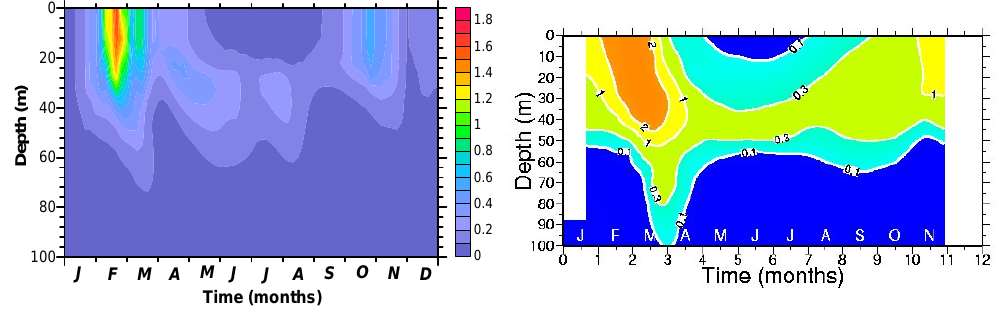
Figure 17 demonstrates seasonal variability of the nitrate and zooplankton concentrations in the upper layer of the Black Sea. Surface concentration of nitrate increases during the winter mixing period and reduces to small value after the spring bloom of phytoplankton. Then it remains negligible until the next winter. The distribution of zooplankton follows closely that of phytoplankton with a time lag of approximately half a month. These seasonal cycles of the phytoplankton, zooplankton and nitrate in the upper layer of the Black Sea derived from the modeling qualitatively correspond to those obtained from measurements (Oguz et al. 1999). Fig. 17. Seasonal cycles of averaged over the basin area nitrates (left panel) and zooplankton (right panel).